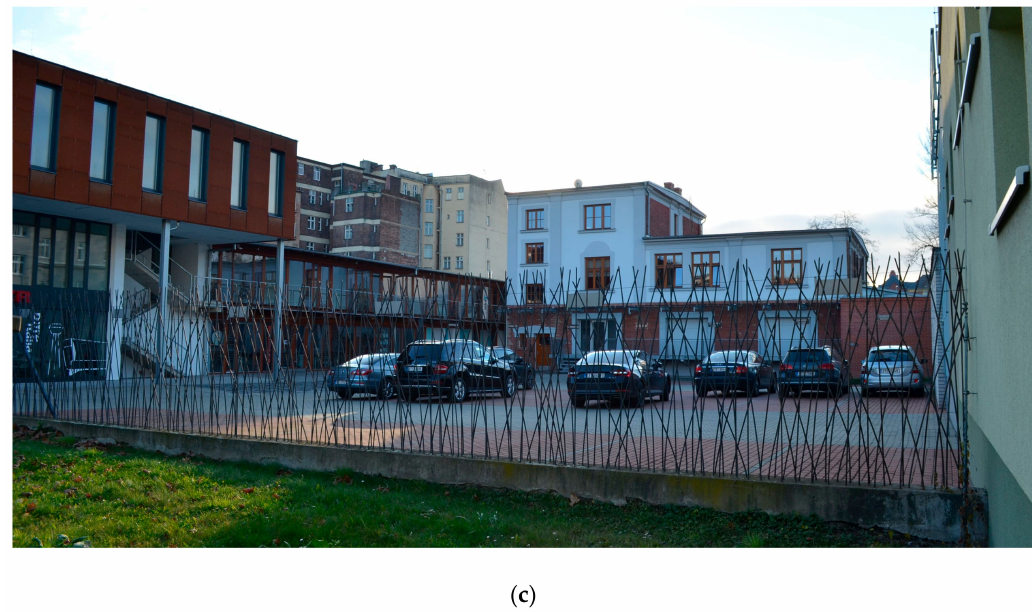
Figure 6. Hub B: selected buildings hosting ICT firms: ( a ) location B1, ( b ) location B2, ( c ) location B3.